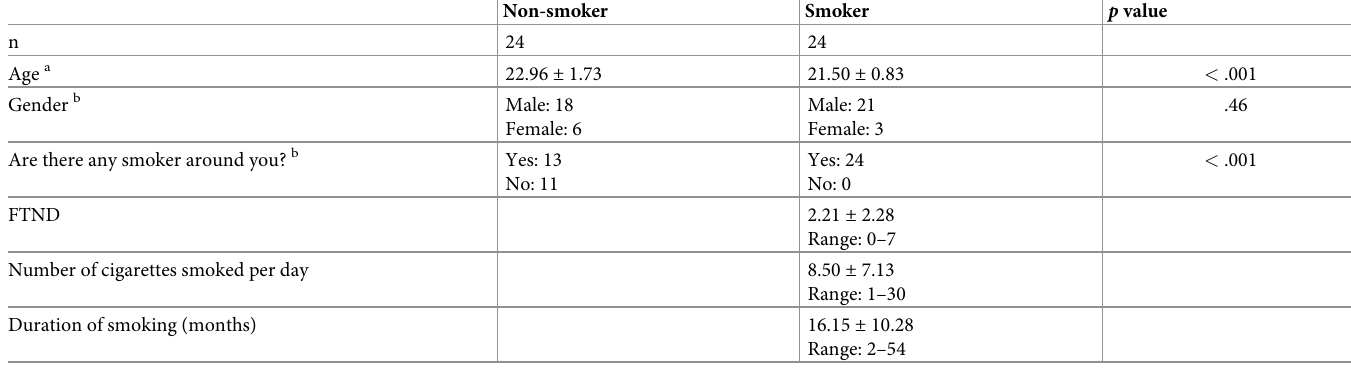
Table 1. Participants’